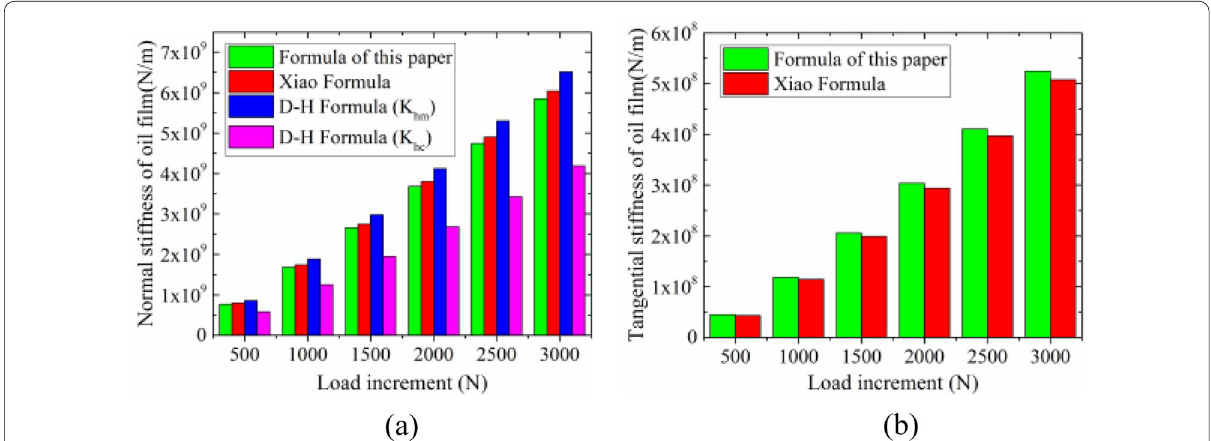
Figure 8 Comparison of oil film stiffness under different calculation